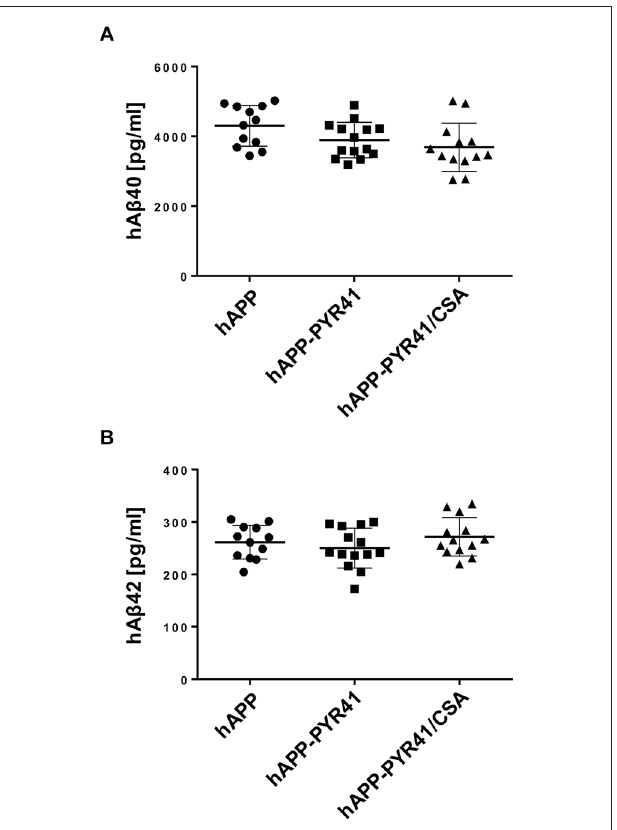
FIGURE 5 | PYR41 treatment has no effect on A β plasma levels. (A) hA β 40 levels (pg/ml) in plasma samples from hAPP mice treated with vehicle, PYR41, or PYR41/CSA determined by ELISA. Data are given for each animal (hAPP: n = 12; hAPP-PYR41: n = 14; hAPP-PYR41/CSA: n = 13). (B) hA β 42 plasma levels (pg/ml) in samples from hAPP mice treated with vehicle ( n = 12), PYR41 ( n = 14), or PYR41/CSA ( n = 13). Statistics: ANOVA; Data between groups are not significantly